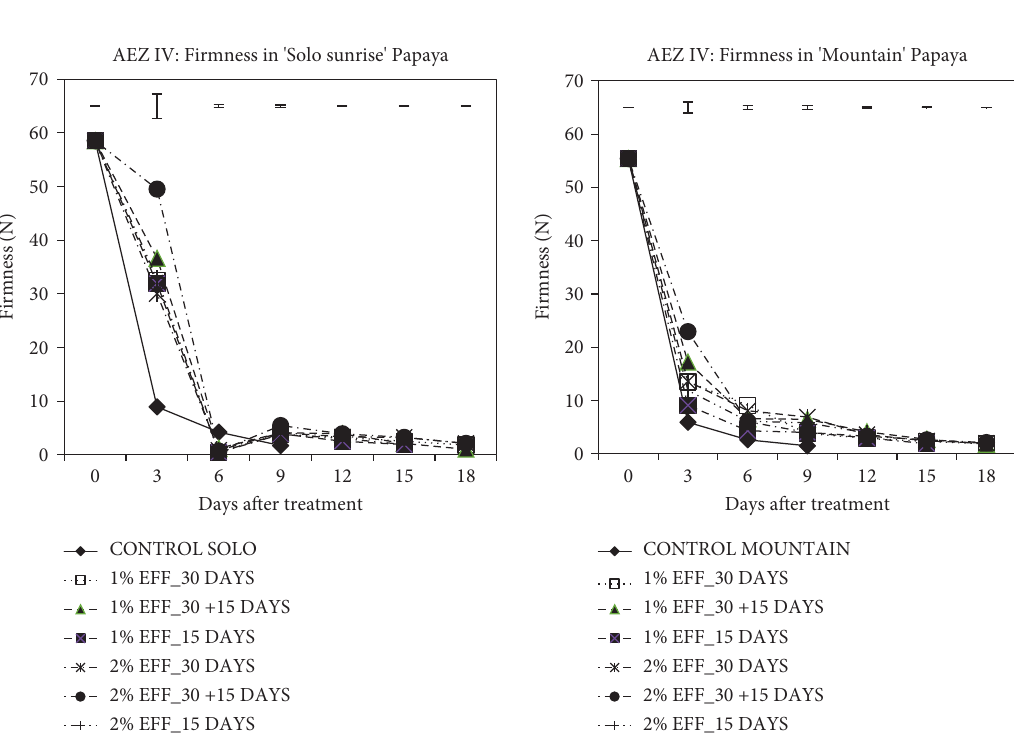
Figure 1: Papaya firmness N for Hexanal sprayed fruits from Machakos and Meru counties. Top bars represent LSD at